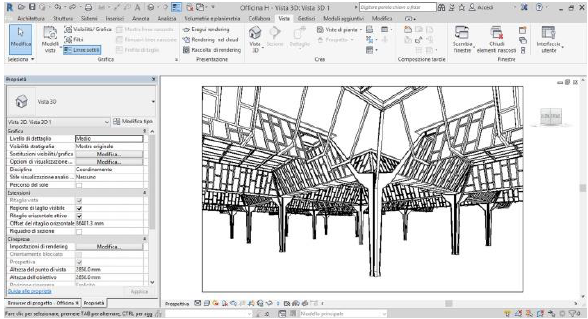
Figure 14: the BIM model of the Officina